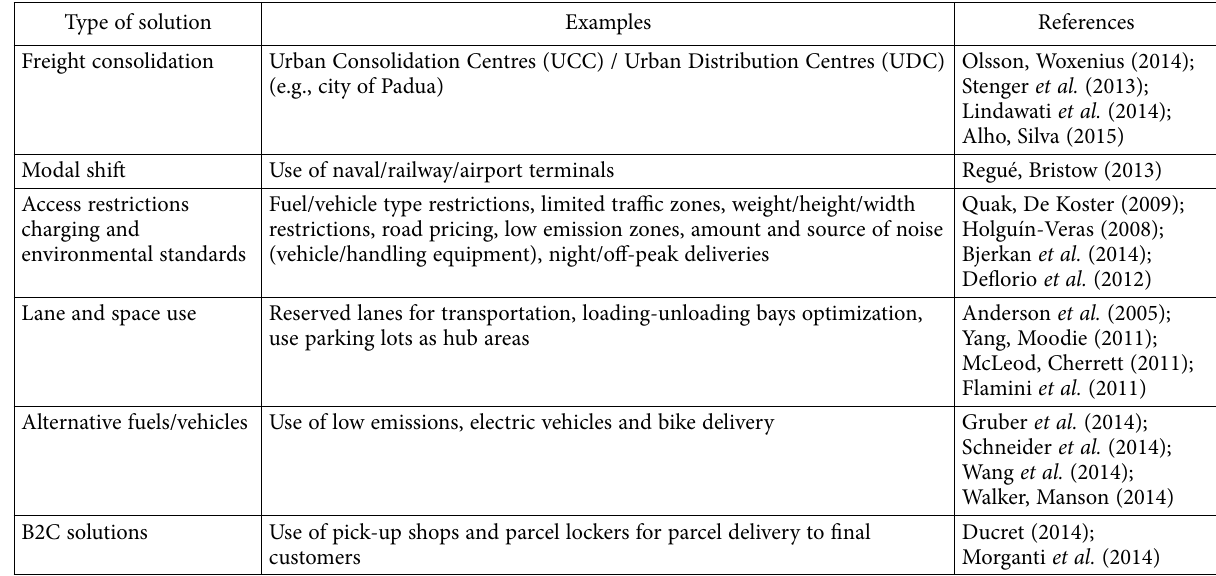
Table 1. UFT solutions, which found larger application in the literature and in practice Type of